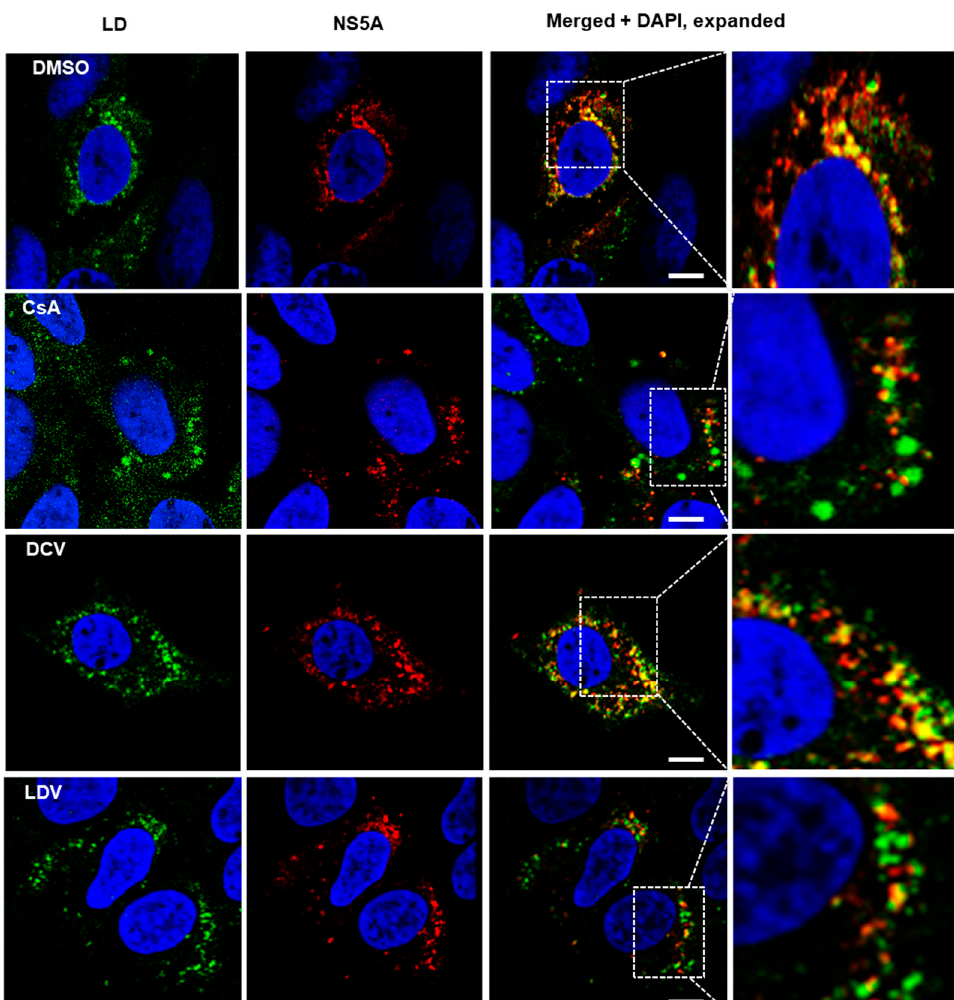
Figure 3. The distribution of NS5A and lipid droplets (LDs) following treatment with CsA and NS5A inhibitors. HCV-infected cells were treated for 8 h with DMSO, or 100 × EC 50 DCV, CsA, and LDV. Cells were then fixed and stained with BODIPY 493/503 neutral lipid stain to label the LDs (green) and anti-NS5A antibodies (red), and with Hoechst-33258 to label the nuclei (blue). Images were acquired on a Leica TCS SP8 microscope with a 63× oil objective. Merged images and expanded merged images show the localization of NS5A and LDs. The scale bar represents 10 µm. DCV, daclatasvir; CsA, cyclosporin A; LDV, ledipasvir.